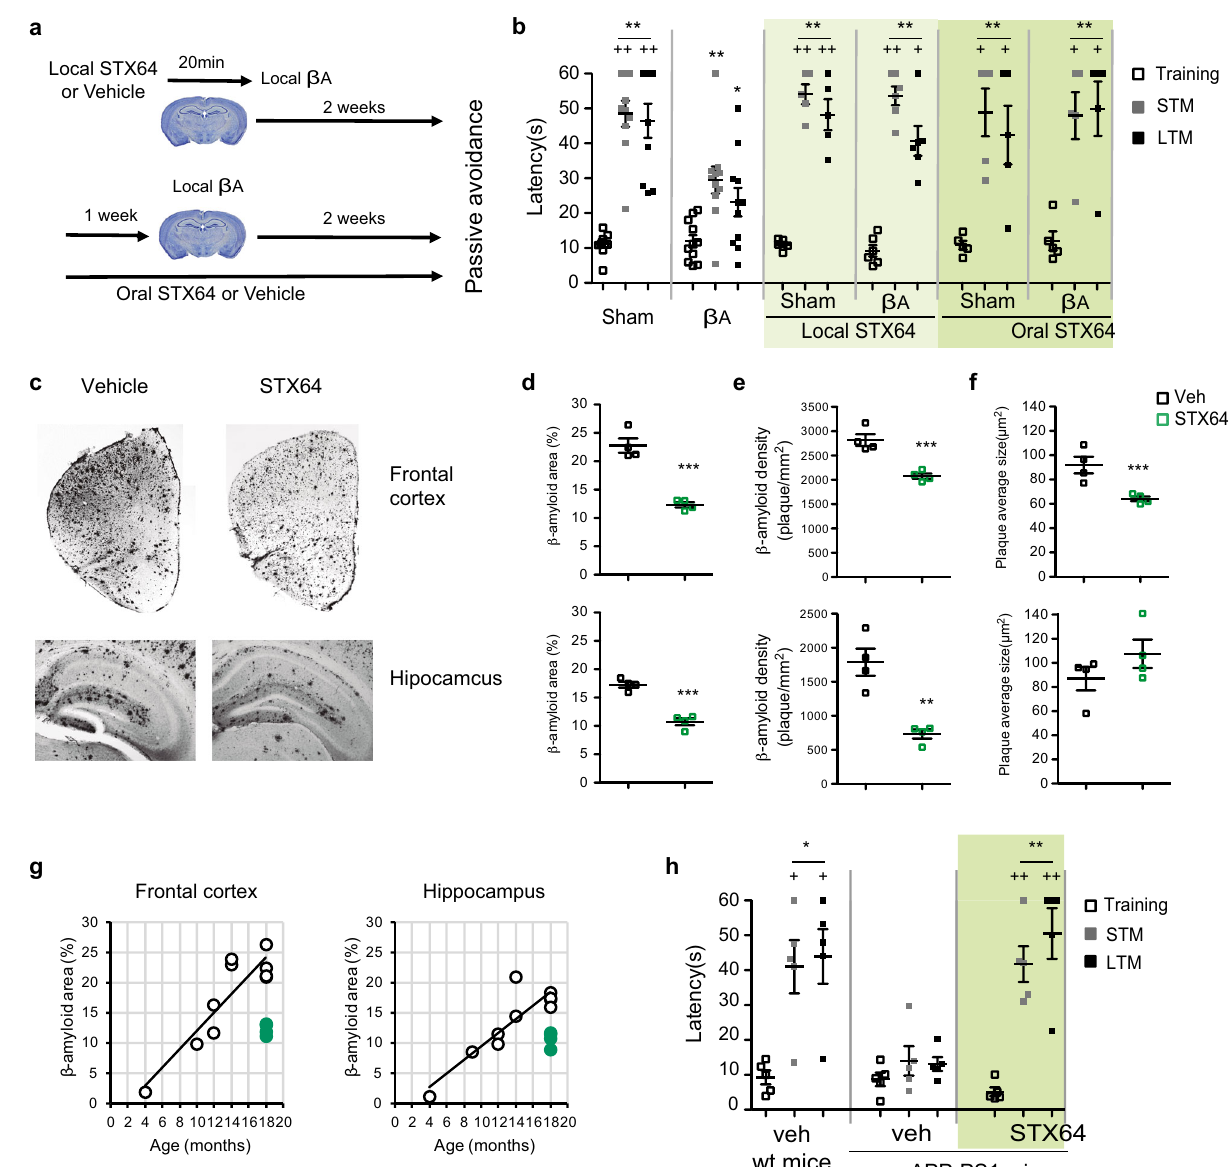
Fig. 4 Reduction of steroid hormone sulfatase activity ameliorates proteotoxicity in murine models. a , b The effect of intrahippocampal and oral administration of STX64 in the passive avoidance test in wild-type mice injected with β -amyloid oligomers in the hippocampus; n ≈ 5 mice per groups. Two-tailed Tukey ’ s test. c Representative β -amyloid-immunoreactive images assessed in the frontal cortex and the hippocampus of APP-PS1 mice older than 15 months of age after 3 – 4 weeks of vehicle or STX64 intake (0.005mg/ml in drink water). d – f Quanti fi cation of the percentage of β -amyloid area ( d ), deposition density ( e ) and average plaque size ( f ) in the frontal cortex and the hippocampus of >15-month-old APP-PS1 mice after 3 – 4 weeks of oral administration with STX64 or vehicle. n = 4 mice per groups. Two-tailed unpaired t -test. g Temporal course of β -amyloid deposition in APP-PS1 mice and the effect of 3 – 4 weeks STX64 oral treatment on β -amyloid area in the frontal cortex (upper panel) and the hippocampus (lower panel). The number of microphotographs used was more than three in all the mice used. h Effect of oral administration with STX64 in more than 15-month-old APP-PS1 mice, compared with APP-PS1 and wild-type mice older than 15 months in the passive avoidance test. n = 5 mice per groups. Two-tailed Tukey ’ s test. In histological analysis, * represents signi fi cant differences between vehicle and STX64 administrated APP-PS1 mice. In behavioural test, * represents signi fi cant differences between the short-term and long-term memory sessions (STM and LTM, respectively) and the training session in the same experimental group; + represents signi fi cant differences between the STM and LTM sessions between each experimental group and β -amyloid group. A symbol, p < 0.05, two symbols, p < 0.01, and three symbols, p < 0.001. In all graphs mean ± SEM are displayed. Exact n and p value are included in Source Data fi